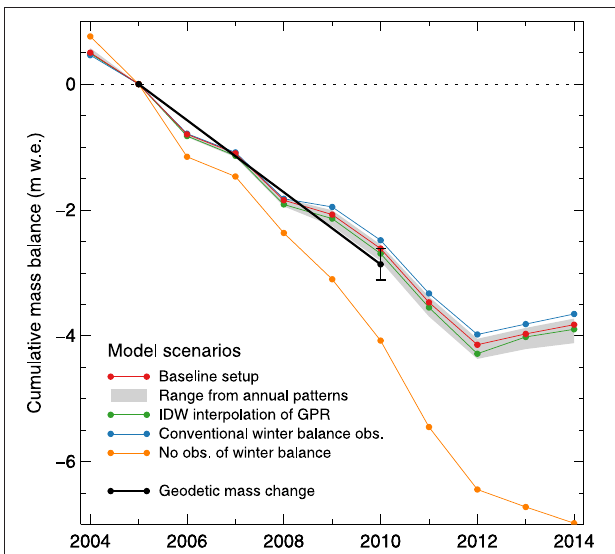
FIGURE 10 | Cumulative mass balance of Findelengletscher for 2004/05 to 2013/2014 obtained from different model setups of snow accumulation: (red) using the GWR-interpolated GPR measurements (baseline scenario) as in Figure 4; (gray) range resulting from using the individual GPR measurements of 1 year for the entire period; (green) using inverse-distance weighting (IDW) for interpolation of GPR measurements; (blue) with conventional winter balance measurements by means of snow probings and density pits; and (orange) with no observations of winter mass balance available and the application of an altitudinal precipitation gradient and fixed precipitation correction instead. The geodetic mass change (black) is given and covers the 2005–2010 period. For visualization, balance series were aligned by the 2005 data